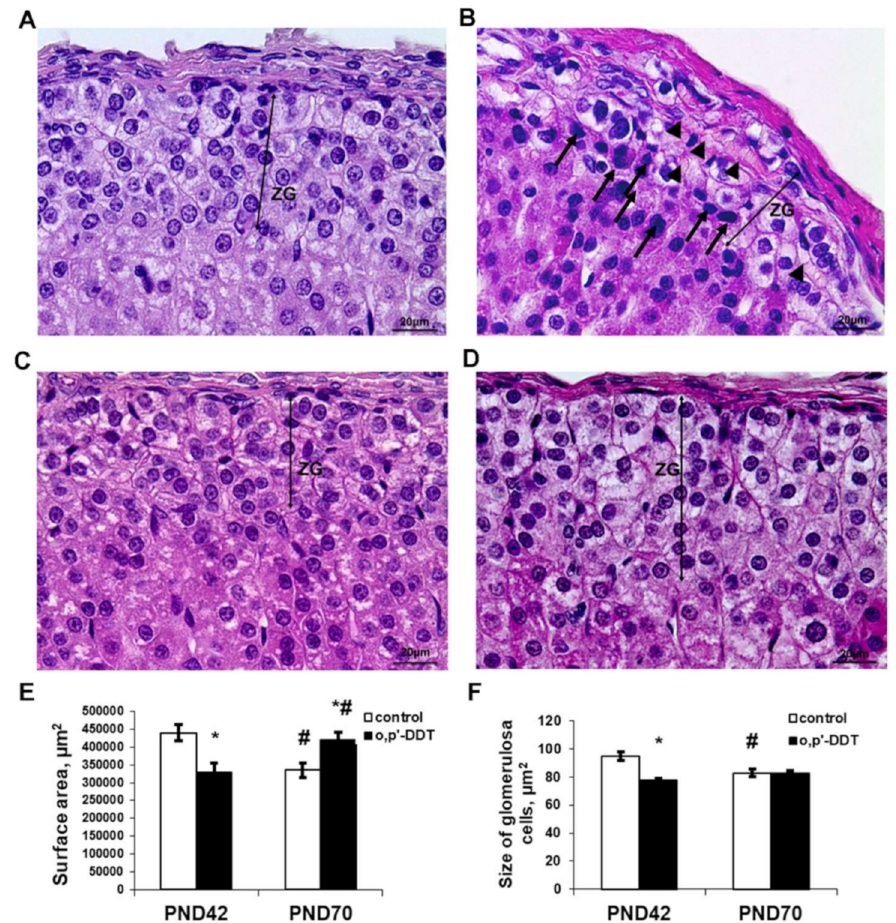
Figure 1. Changes in the histology of the adrenal zona glomerulosa after developmental exposure to low doses of o,p’-DDT. Histology of the zona glomerulosa (ZG) of the control rats ( A ) and DDT- exposed rats ( B ) in pubertal period (PND42), of the control rats ( C ) and DDT-exposed rats ( D ) after puberty (PND70). Arrowheads point to microcirculatory vessels obturated red blood cells with, arrows–picnotic nuclei. Scale bar 20 µ m. ( E ) Surface area of the zona glomerulosa. ( F ) Size of the glomerulosa cell. Data are shown as mean ± S.E.M. PND, day of postnatal development; p < 0.05 compared to the control (*), compared to PND42